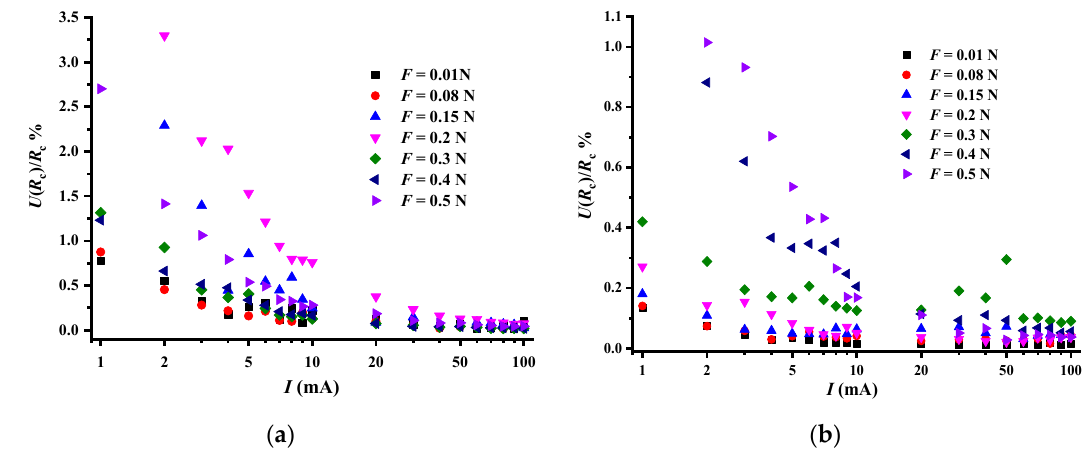
Figure 11. The variation of the expanded uncertainty of the contact resistance with varied contact current. ( a ) Gold-plated rivet. ( b ) AgCdO rivet.